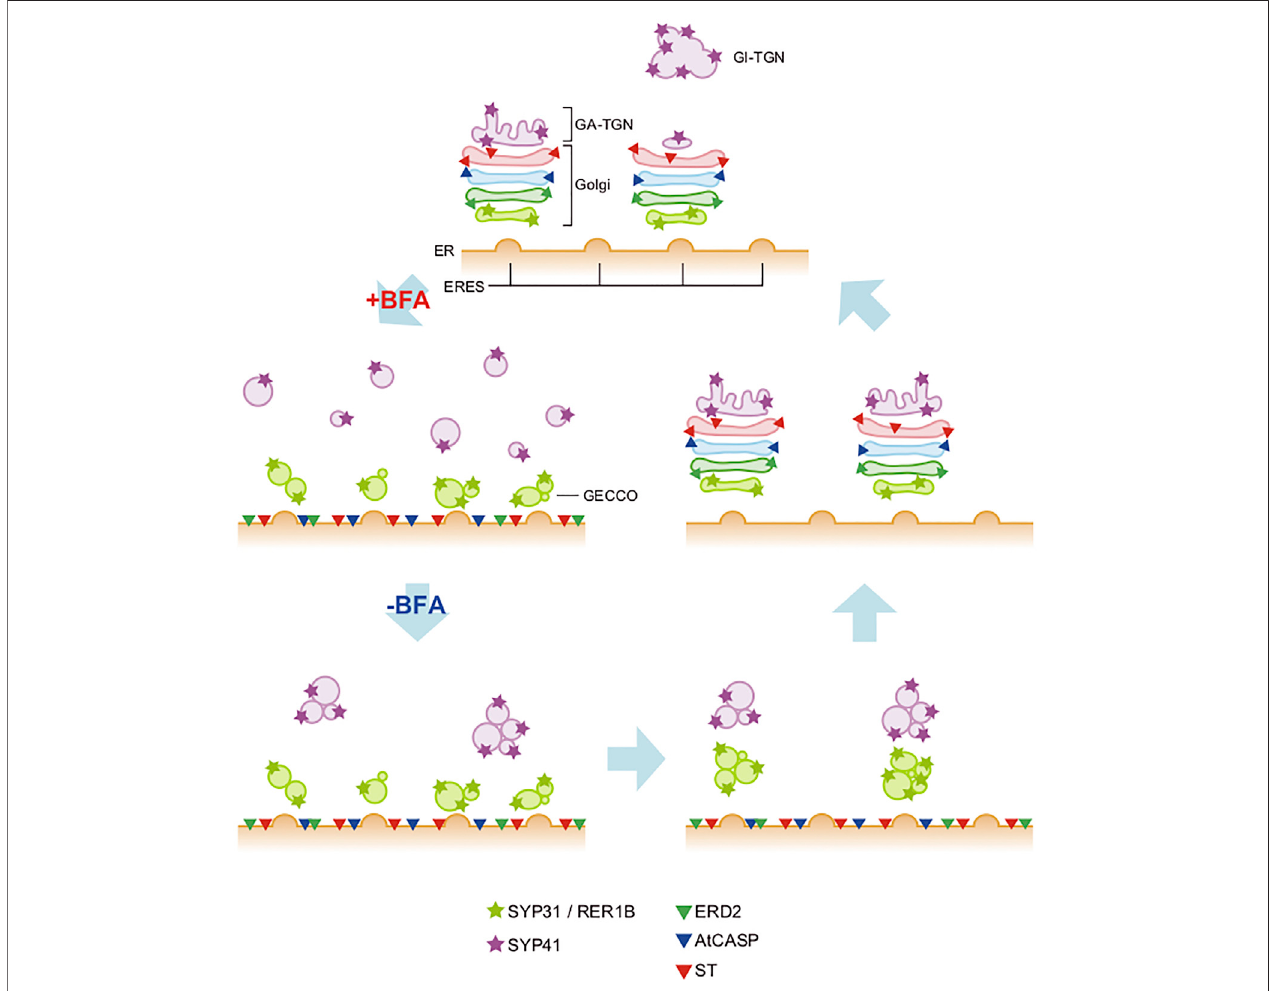
FIGURE2| BehaviorsofGolgiandTGNuponBFAtreatmentandwashoutinplantcells.IntobaccoBY-2cells,BFA-treatmentgivesdistincteffectstothe cis -most Golgi,theGolgi main body, and TGN(+BFA). Themain-bodyGolgi(with the resident proteins shown bytriangles) iscompletely absorbed intothe ER,whereas cis -most Golgi, marked by SYP31 and RER1B (light green stars), remains as punctate structures near the ERES, which we designate GECCO (Golgi entry core compartment). TGN (marked by purple stars; SYP41), on the other hand, gets fragmented into small vesicles and dispersed in the cytoplasm. When BFA is washed out (-BFA), these components regenerate the original structures but their processes are again quite different. The Golgi main body reforms stacks in the cis -to- trans direction using the GECCO asthe regeneration scaffold. TGN reassemblesby itself independent of the GECCO and the Golgi main body, but fi nally meets Golgi and starts staying side by side (Ito et al., 2012; Ito et al., 2017; Ito et al., 2018b). GA-TGN, Golgi-associated TGN; GI-TGN, Golgi-independent TGN (see Figure 3 ).